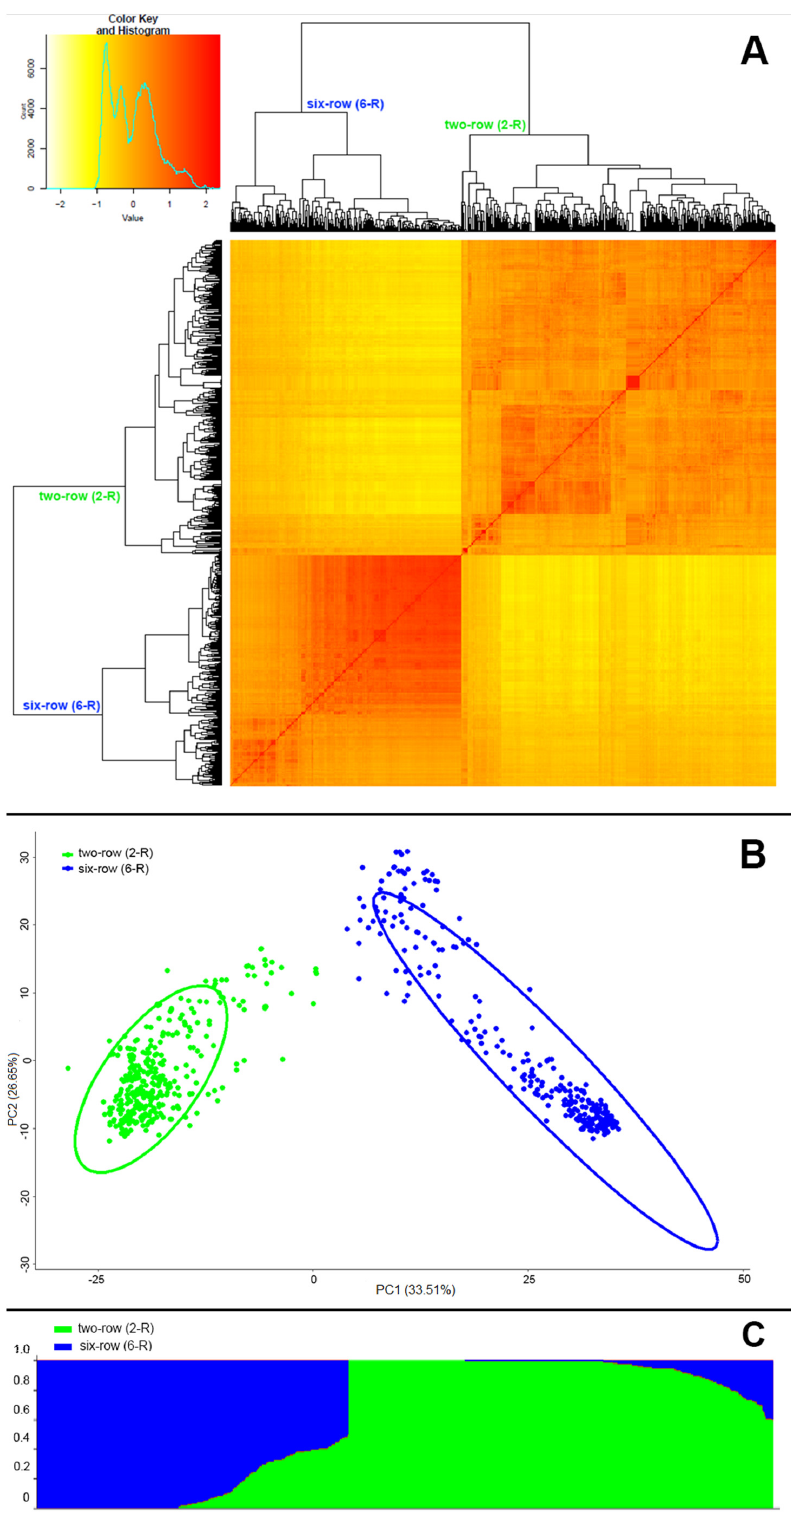
Figure 4. Population structure in studied barley collection. ( A ) Heat map of the kinship matrix (K-matrix) with dendrogram. ( B ) PCA plot. ( C ) STRUCTURE barplot.